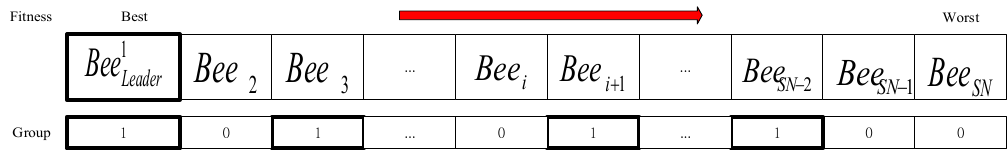
Figure 10. Similar bees are put in the same group.